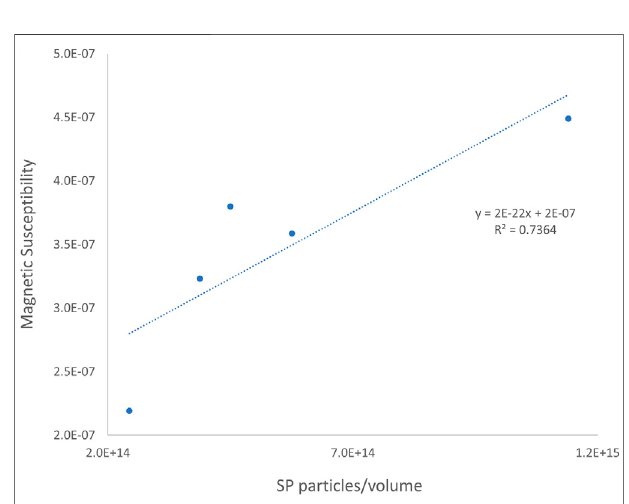
FIGURE 6 | Linear correlation between magnetic susceptibility and SP particles content, for the samples from the vadose zone.